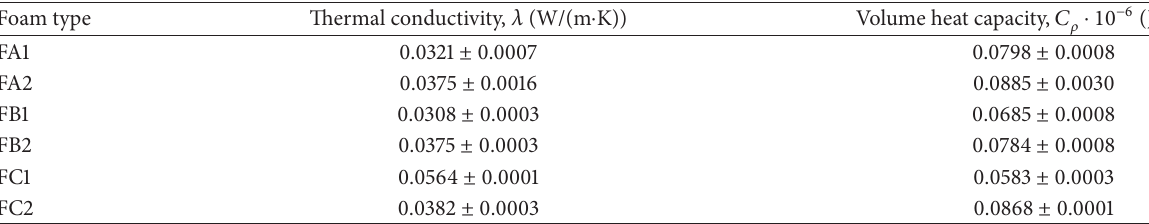
Table 9: Insulation parameters.